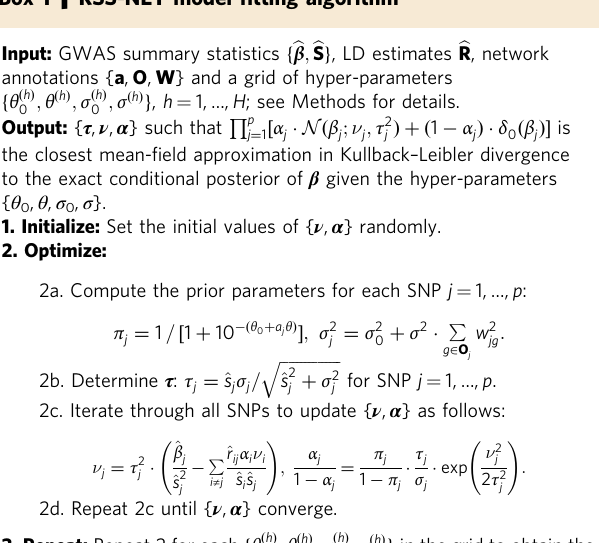
Box 1 | RSS-NET model fi tting